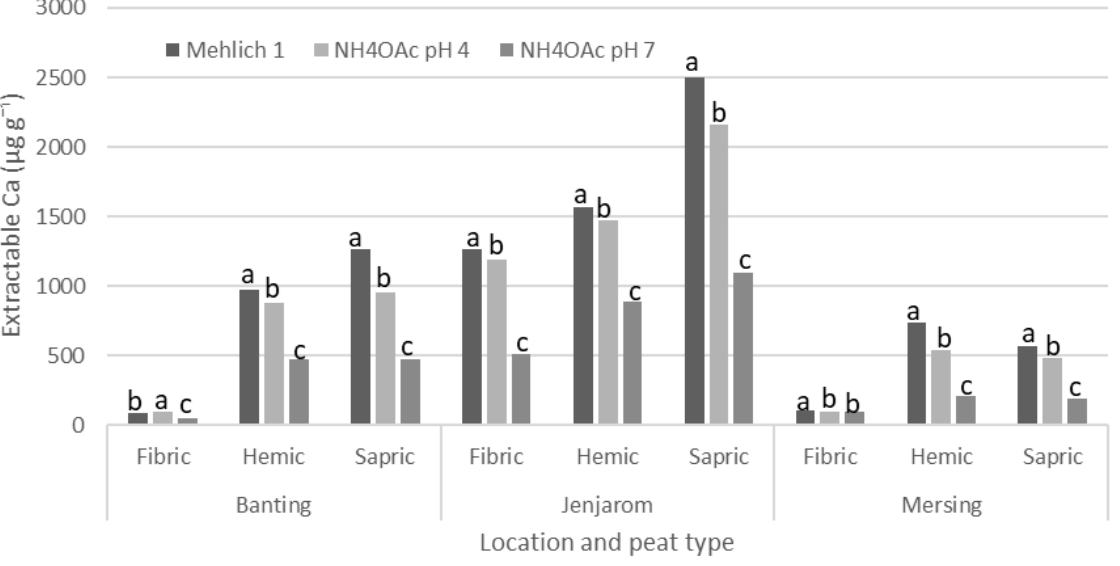
Figure 2. Comparison of the amounts of Ca 2+ obtained, using three different extractants, from Fibric, Hemic and Sapric peat collected at three different locations (Banting, Jenjarom, Mersing) in peninsular Malaysia. Different letters (per peat type and location) indicate significant differences between means (Tukey’s test at P =